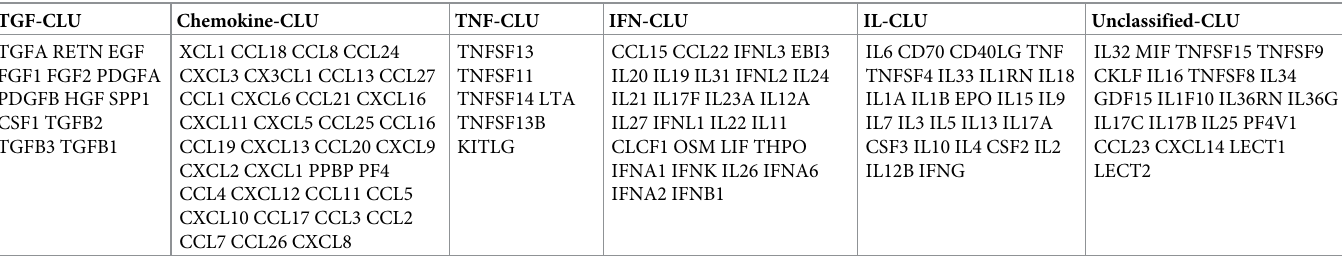
Table 2. Specific cytokines in each of the six clusters.